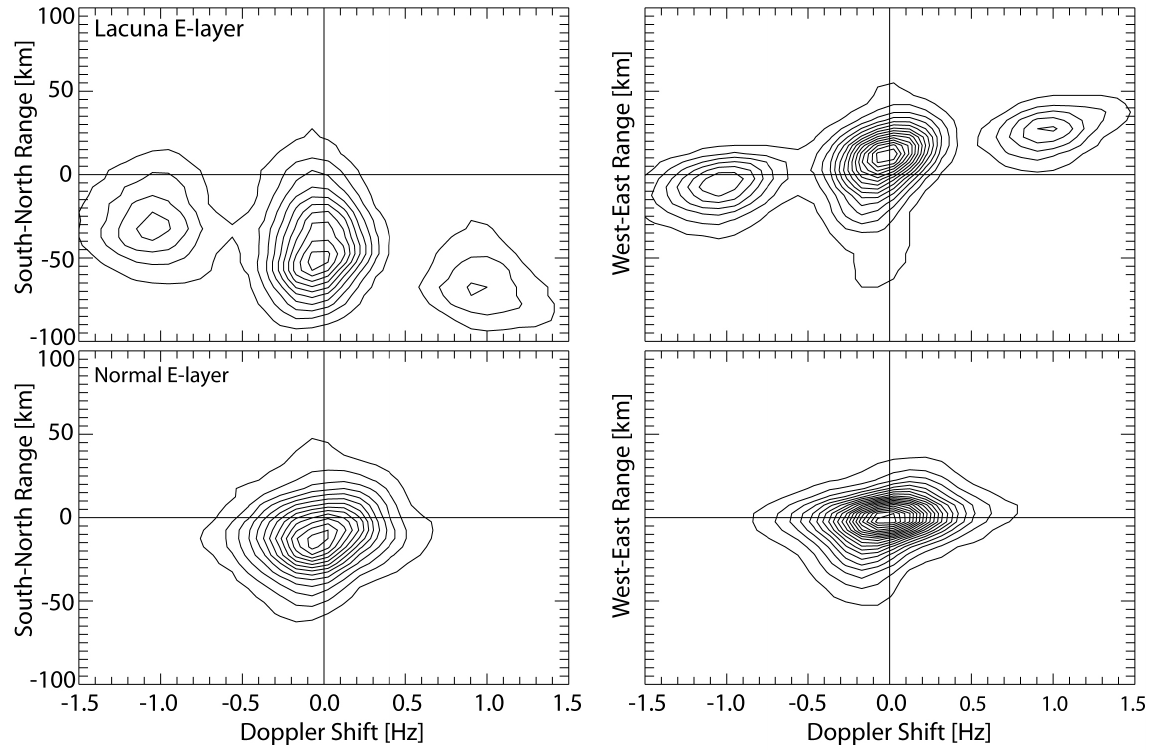
Fig. 10. Comparison between compass north-south and east-west range echo-location distributions as a function of Doppler shift observed between 02:05 and 04:10 UT on 16 (top) and 17 (bottom) December 1996 (constructed from 12581 and 10280 sky sources, respectively), and distributed in 10-km by 0.1-Hz Doppler-range